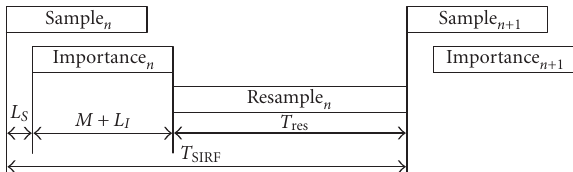
Figure 12: Timing of operations in